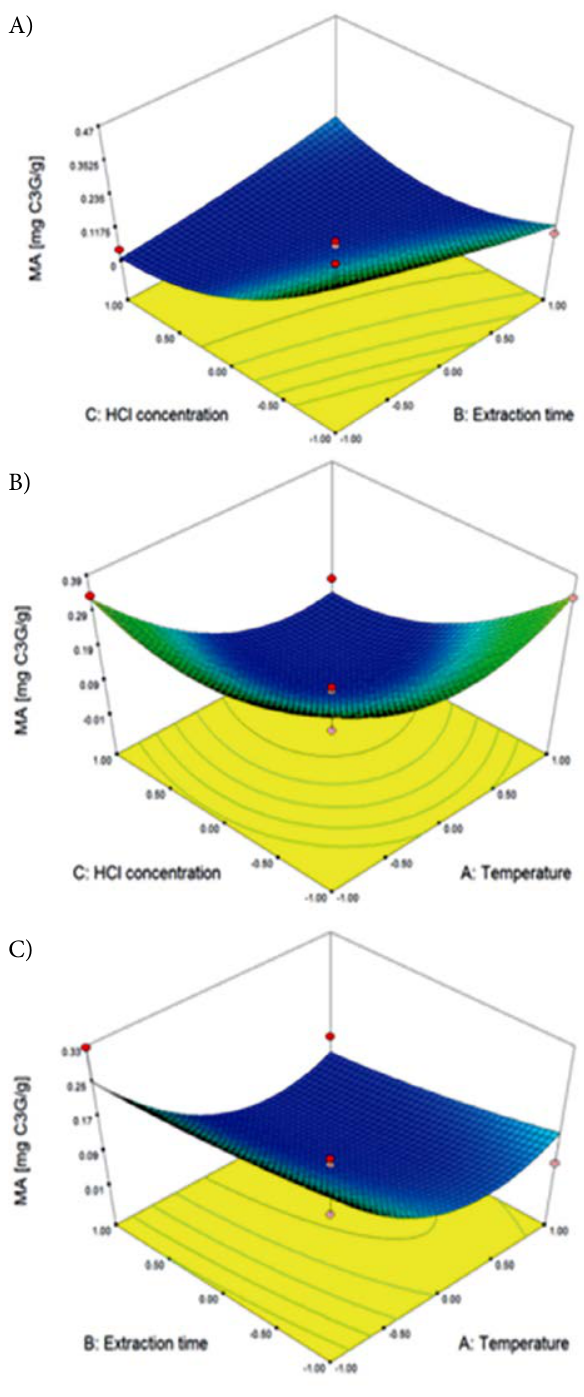
Figure 4 Response surface plots showing combined effects of pro- cess variables: (A) HCl concentration and extraction time, (B) HCl concentration and temperature and (C) extraction time and tem- perature on monomeric anthocyanins